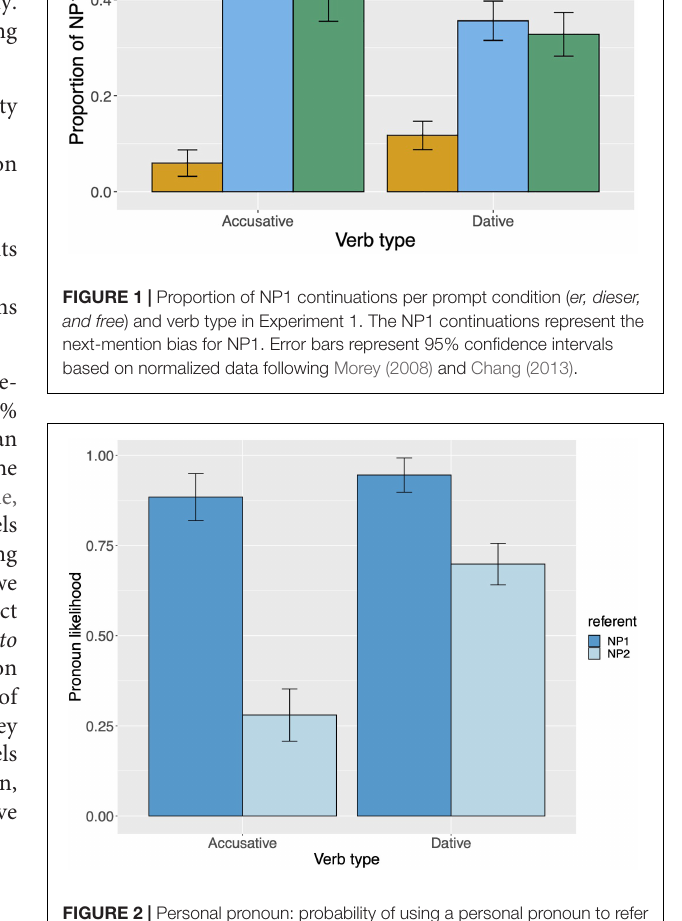
FIGURE 2 | Personal pronoun: probability of using a personal pronoun to refer to NP1 and NP2, per verb type, for Experiment 1. These bars represent the pronoun production likelihoods (and are therefore based on the free-prompt data). Error bars are by-participant and represent 95% confidence intervals based on normalized data following Morey (2008) and Chang